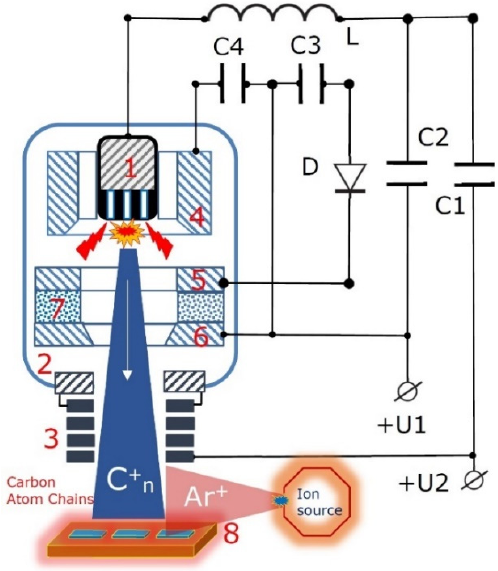
Figure 6. Schematic representation of the pulse-plasma generator installed in the reactor of the experimental set-up (Figure 5): 1—a cylindrical main discharge cathode (evaporated material, the high purity graphite) containing cylindrical rods manufactured from various materials and used for heteroatom doping; 2—the main discharge anode; 3—a solenoid final focusing system with plasma neutralization; 4—second auxiliary discharge anode; 5—ignition cathode; 6—ignition anode; 7—dielectric insulator; 8—substrate holder.